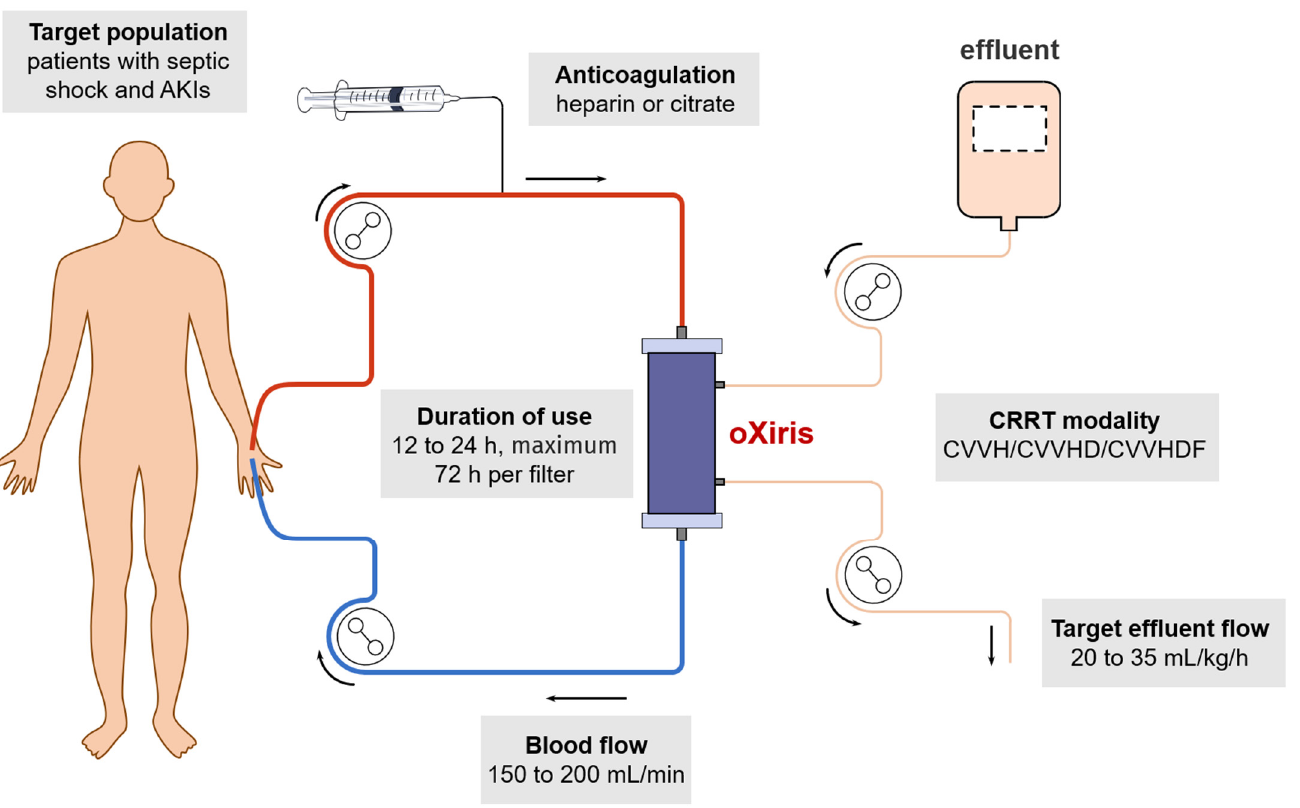
Figure 1. Key recommendations for the delivery of oXiris-CRRT by the Asia–Pacific expert consen- sus [9].